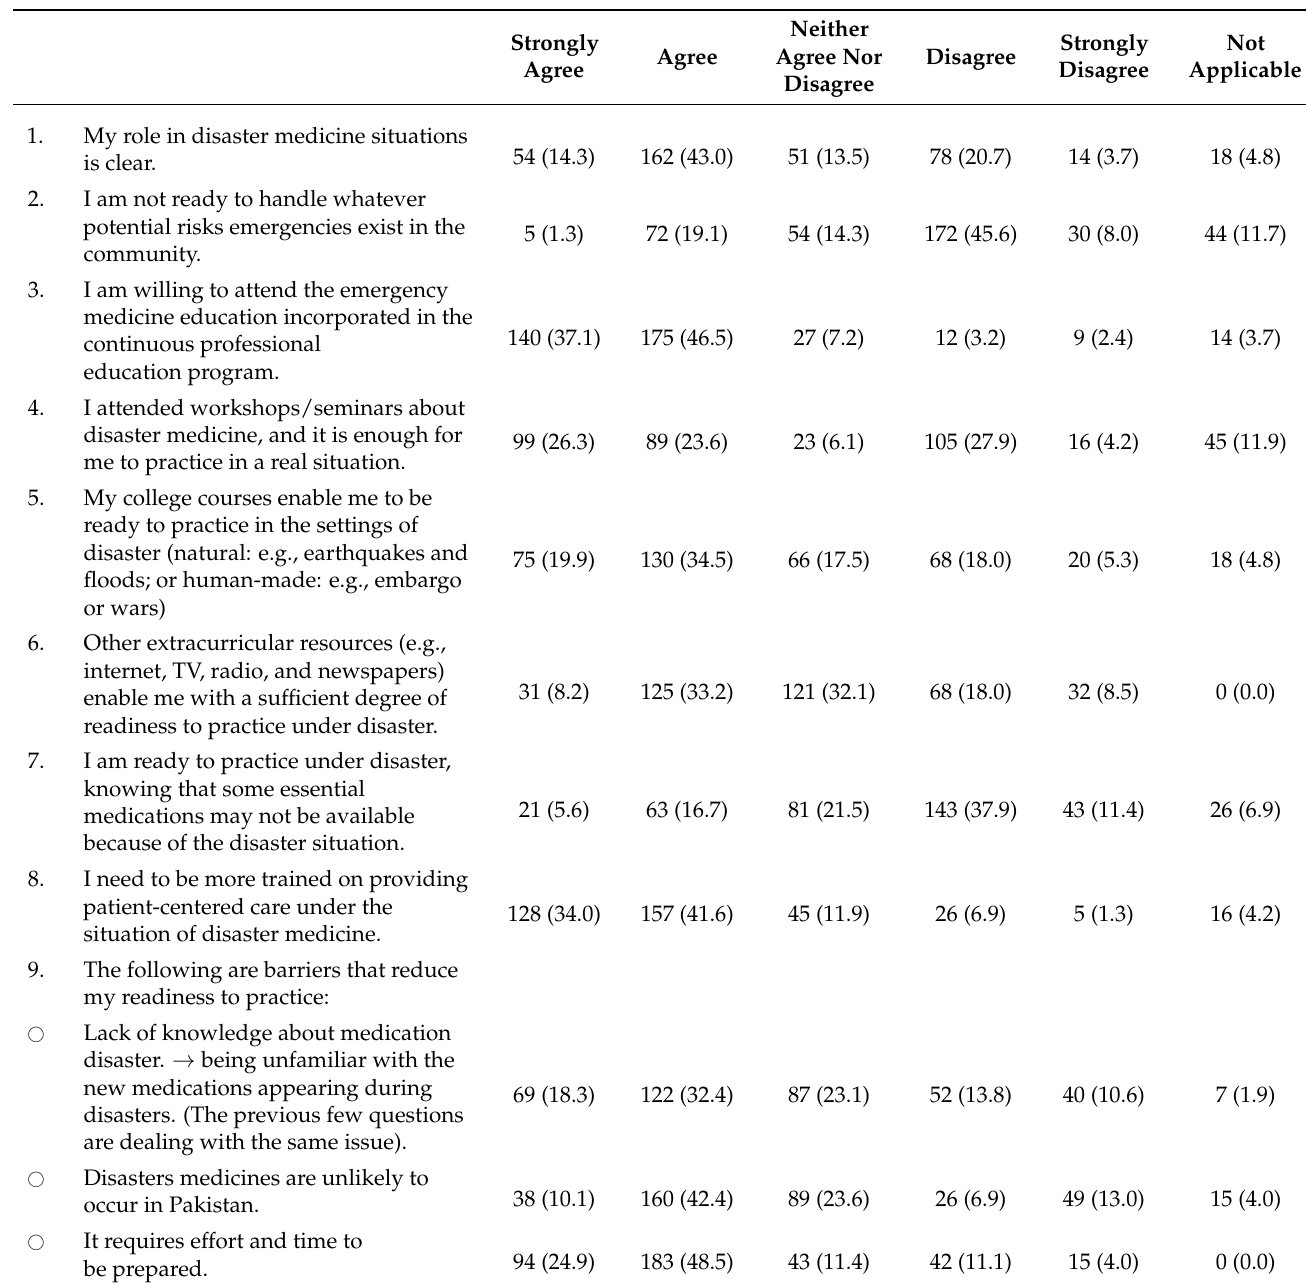
Table 4. Readiness to practice assessment of the respondents regarding disaster medicine